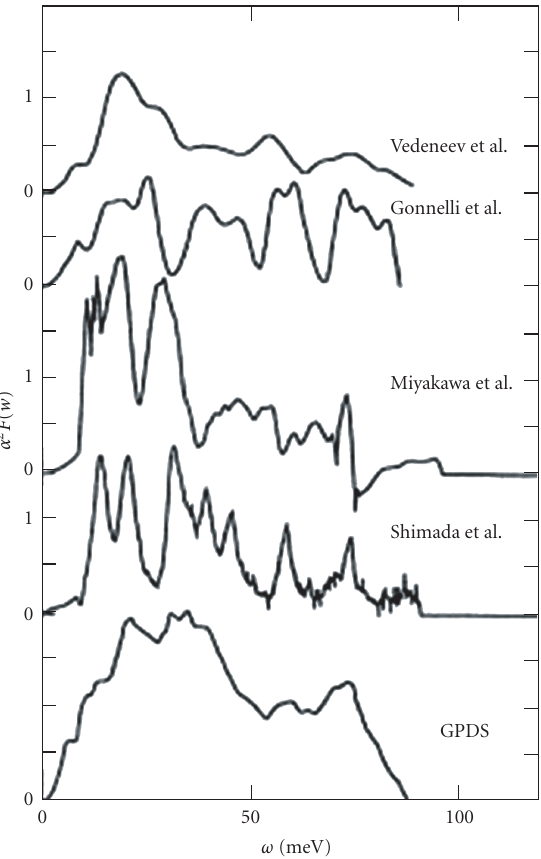
Figure 23: The spectral functions α 2 F ( ω ) from measurements of various groups: Vedeneev et al. [42–45], Gonnelli et al. [52], Miyakawa et al. [48, 49], and Shimada et al. [46, 47]. The generalized density of states GPDS for Bi 2212 is at the bottom. From [46,